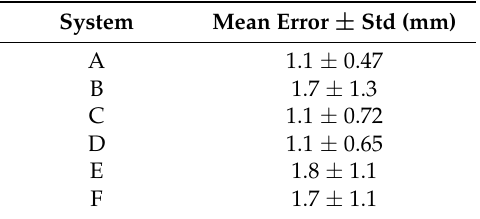
Table 3. Overall mean error across the entire MR volume for the different MRI